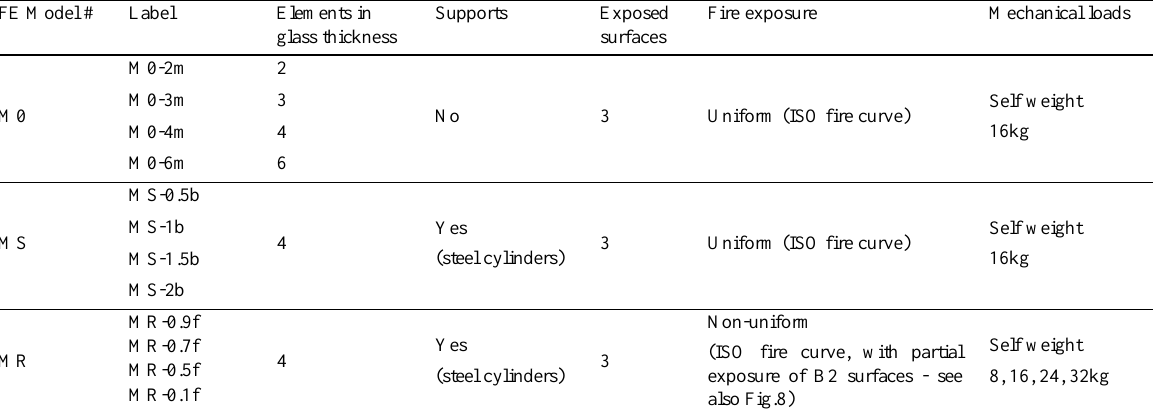
Table 2: Summary of parametric FE models